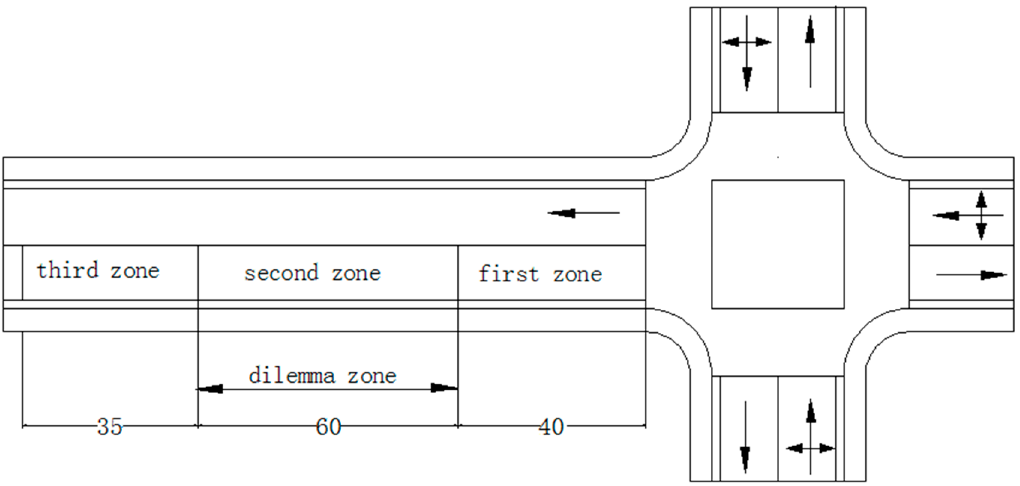
Figure 3. Three zones of the western approach to the intersection before the stop line.